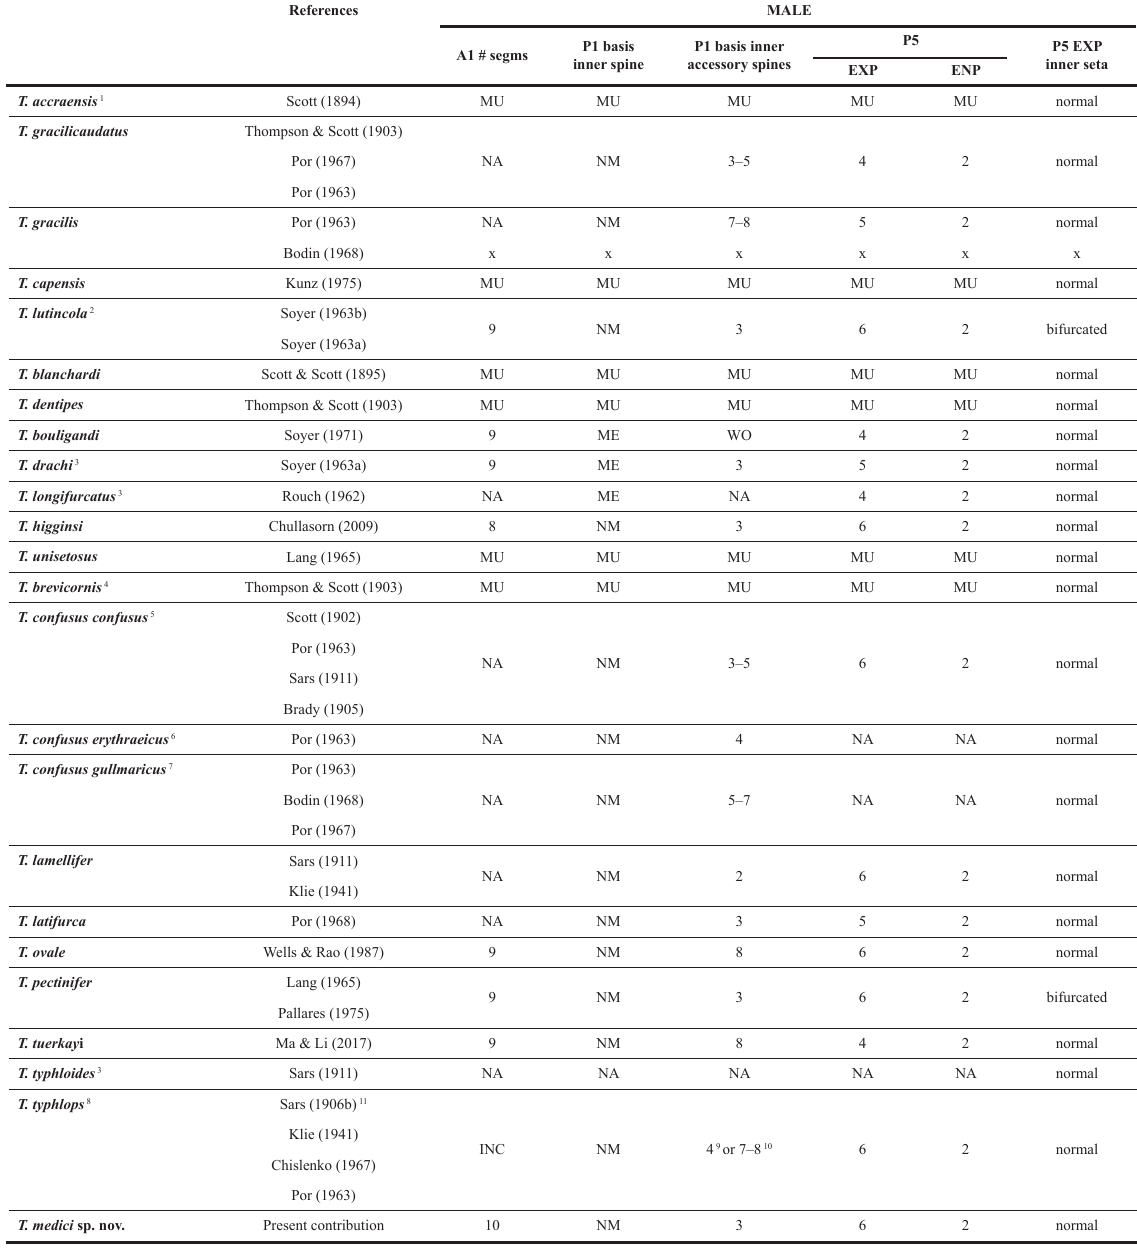
Table 2. Main diagnostic characters (males) of the species of Typhlamphiascus considered in this study. Abbreviations: INC = inconclusive; ME = modified, elongate; MU = male unknown; NA = not available; NM = not modified; segms = segments; WO =